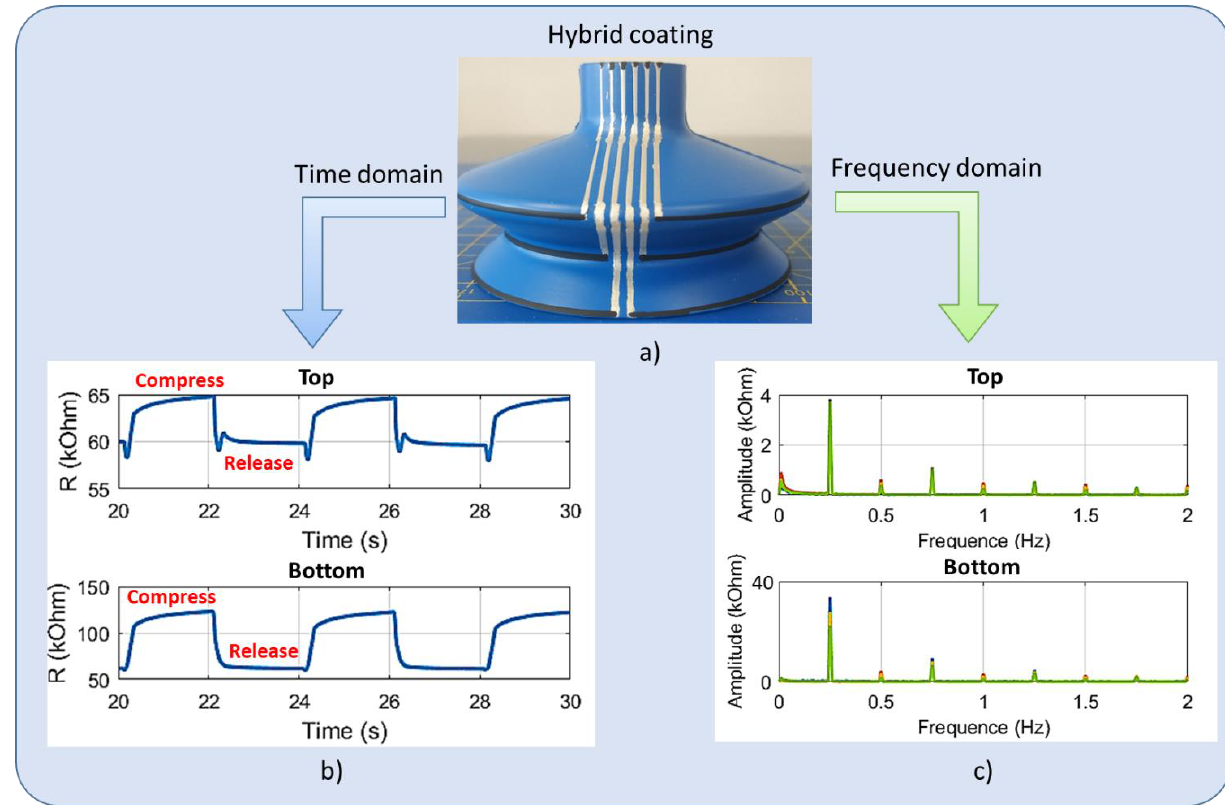
Figure 16. Time and frequency domain analyses of the top and bottom resistances for the hydride- coating suction cup: ( a ) printed sample, ( b ) resistance versus time, and ( c ) resistance change through FFT analysis.